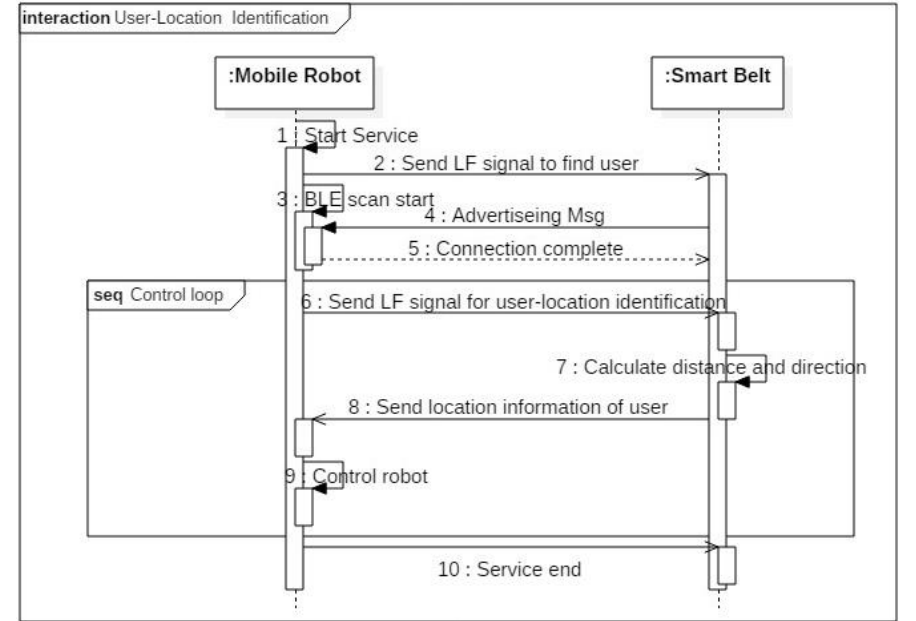
Figure 7. Sequence diagram for finding the user’s location.